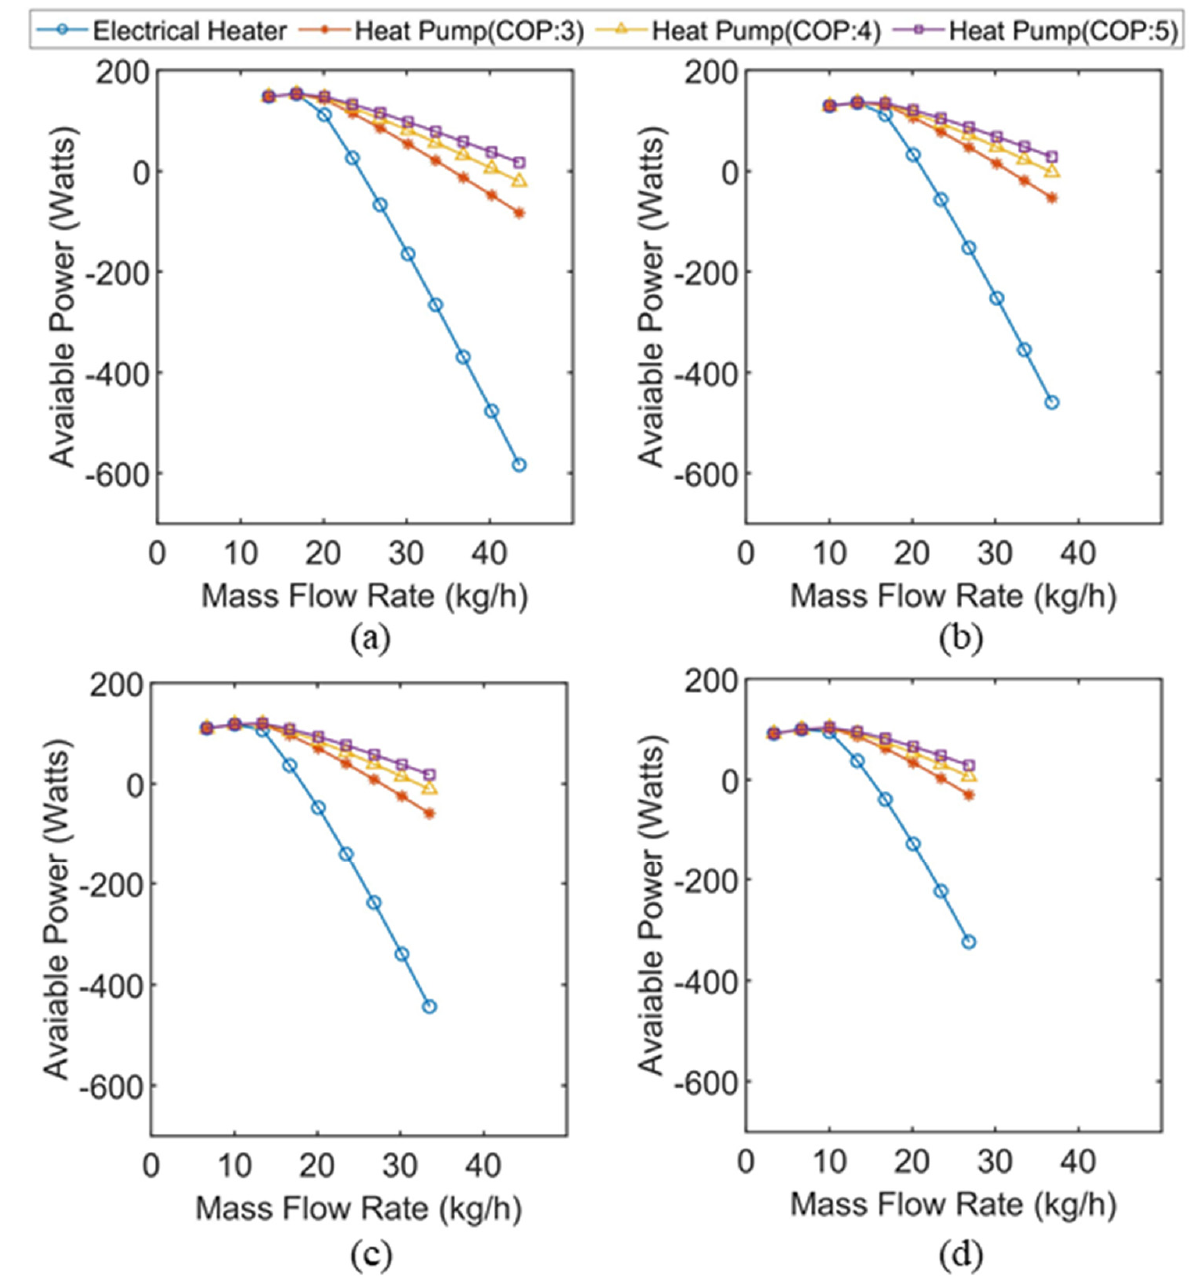
Figure 8. Available electrical power after delivering domestic hot water by different backup systems coupled with glazed PVT system at irradiance of: ( a ) 1000 W/m 2 ; ( b ) 900 W/m 2 ; ( c ) 800 W/m 2 ; ( d ) 700 W/m 2 .